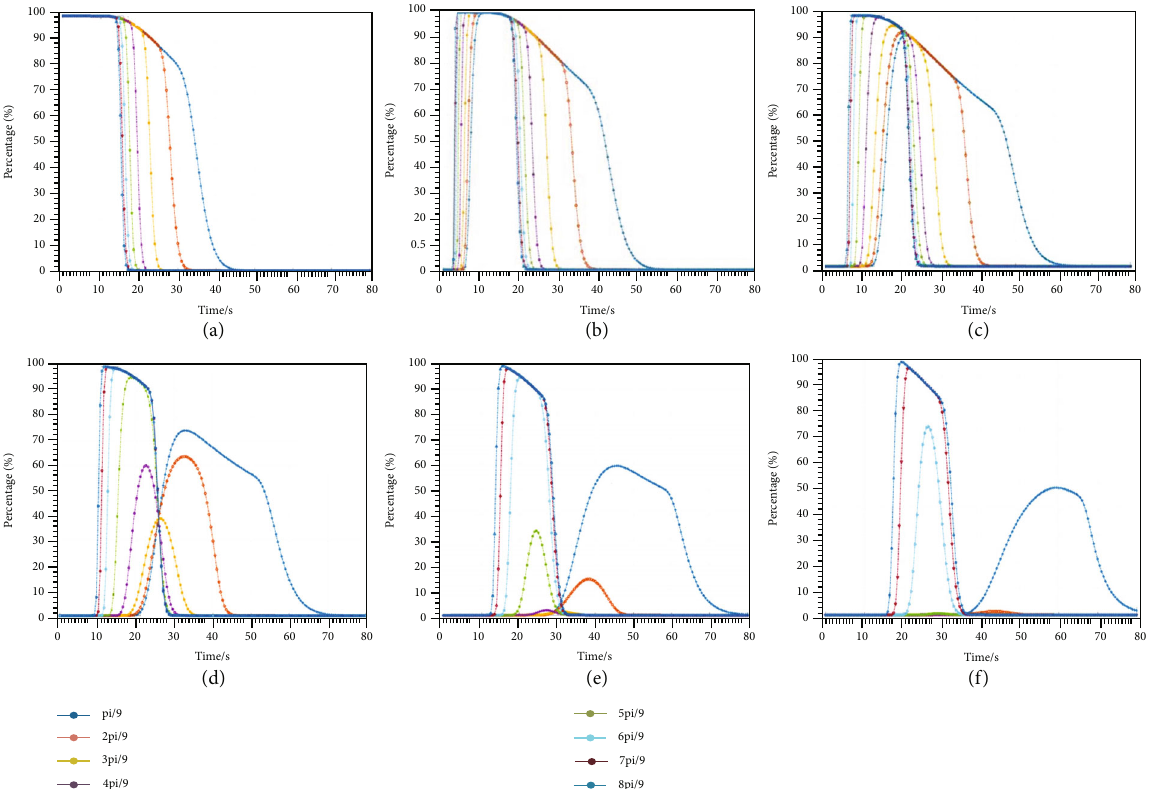
Figure 9: Con fl ict risk assessment of horizontal fl ight in low-level airspace ( flight altitude < 1000 m ) versus θ ∈ ½ π /9, 8 π /9 (cid:2) , H = 0 , θ = θ = 0 , V = 360Km/h , and V = 169Km/h . Results are averaged over 1000 simulations. (a) d = 10 3 ; (b) d = 1 : 5 × 10 3 ; (c) d = 3UAV MAV UAV 2 × 10 3 ; (d) d = 2 : 5 × 10 3 ; (e) d = 3 × 10 3 ; (f) d = 3 : 5 × 10 3